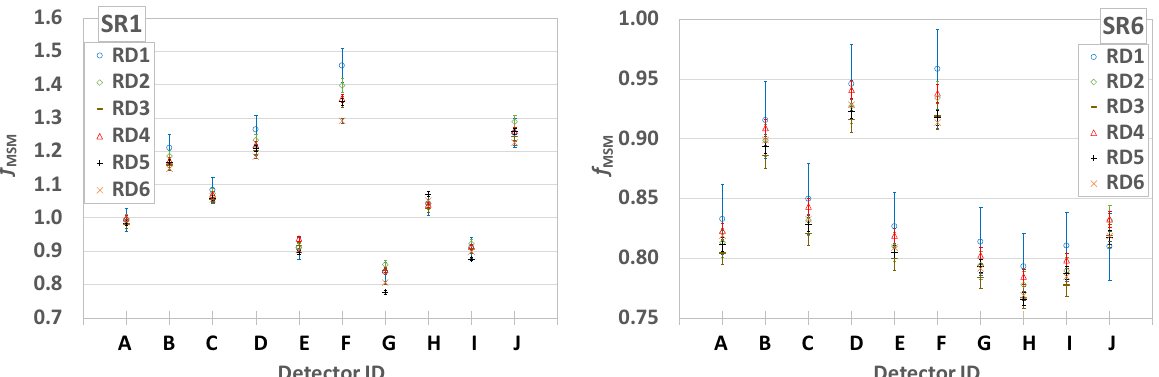
Figure 3. MSM correction factors for SR1 worth (left) and SR6 (right) measured with respect to six different reference sub-critical configurations.